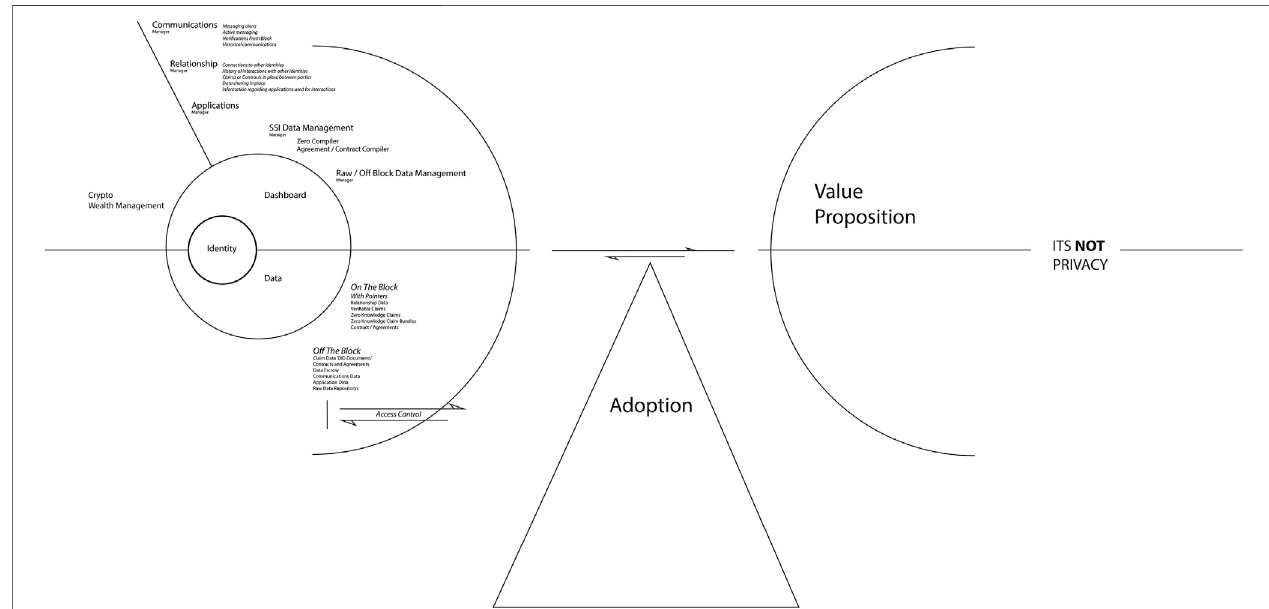
FIGURE 5 | Balancing the cognitive load against the value